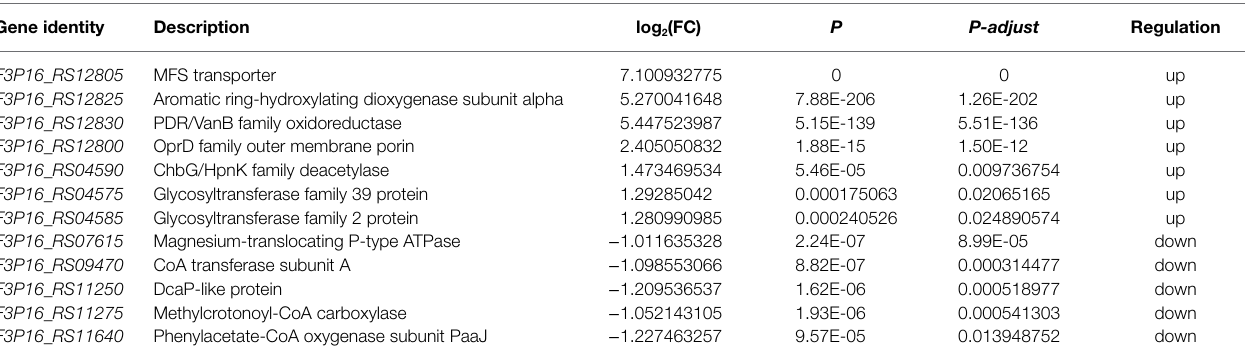
TABLE 4 | Differentially expressed genes identified by